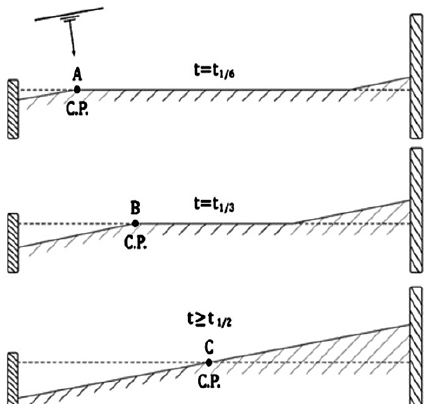
20 and 30 ◦ ) correspond to θ of 52.5, 71.2 and 86.5 ◦ , respec-